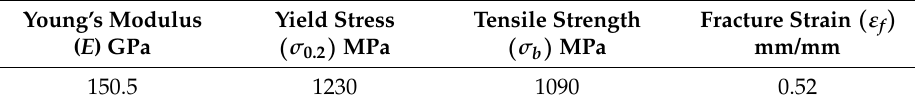
Table 4. Mechanical properties of the GH4169 superalloy (at 650 ◦ C).